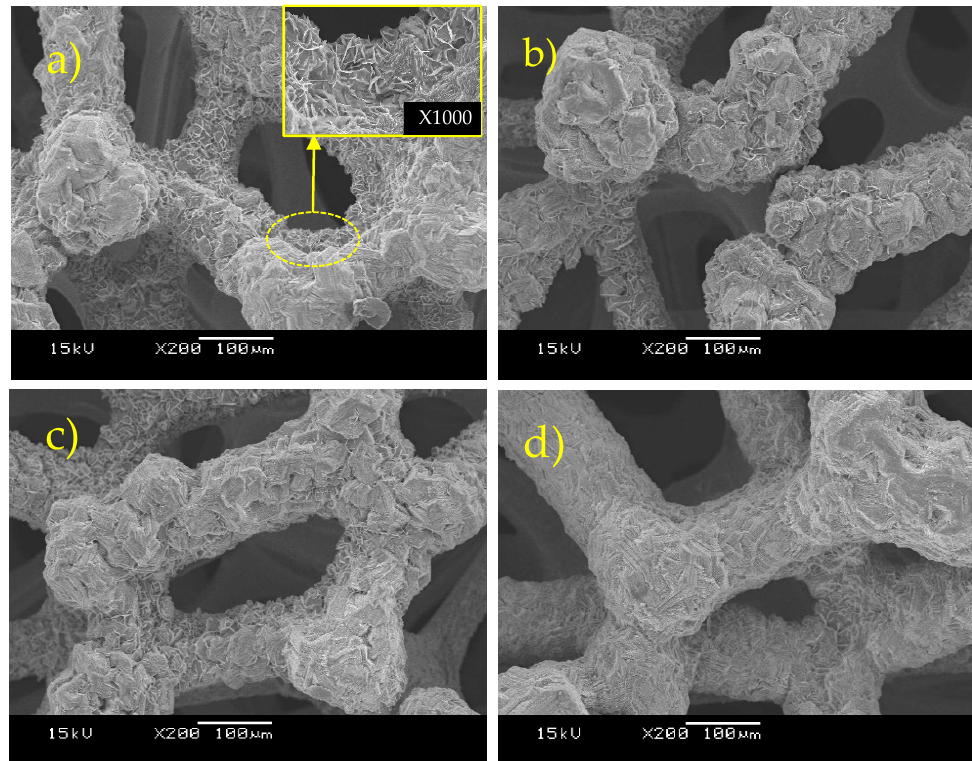
Figure 7. SEM micrographs of the Zn/IF surface (200×), at deposition potentials of ( a ) − 1.60 V vs. Hg/HgO, ( b ) − 1.55 V vs. Hg/HgO, ( c ) − 1.50 V vs. Hg/HgO and ( d ) − 1.45 V vs. Hg/HgO for 30 min in an electrolyte solution.